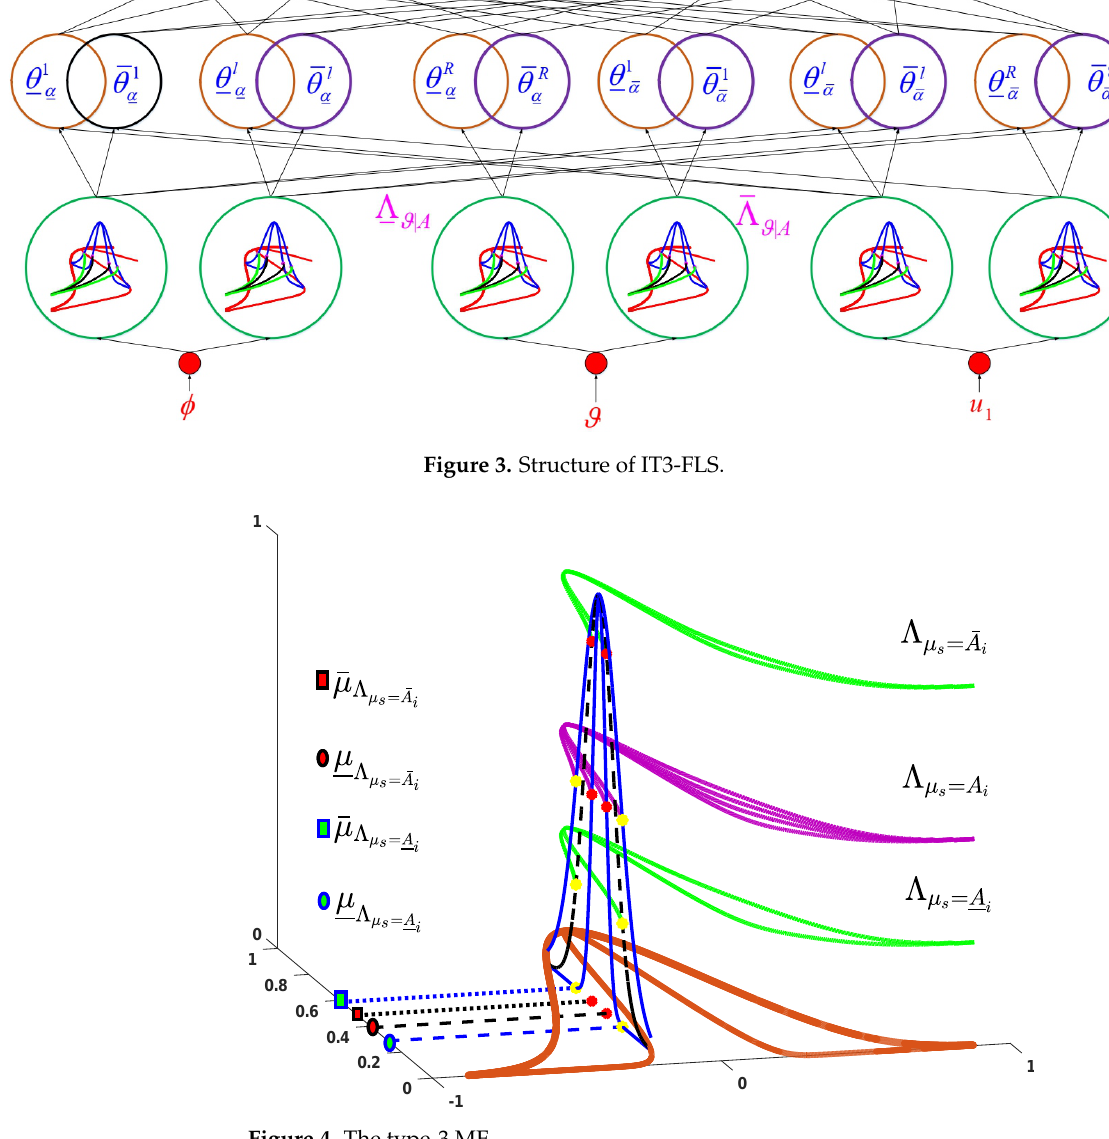
Figure 4. The type-3